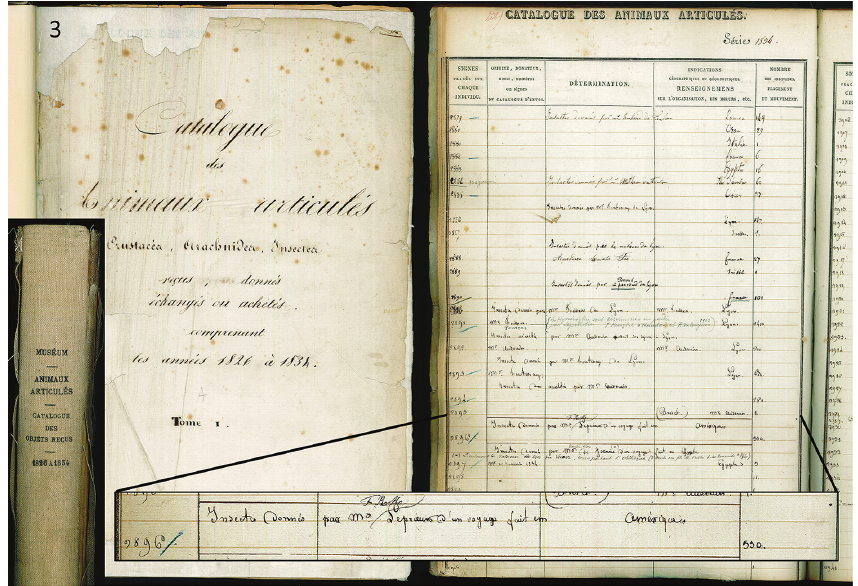
Figure 3. Catalogue des Animaux articulés Crustacéa, Arachnidea, Insectea, reçus, donnés échangés ou achetés comprenant les années 1826 à 1834. Tome I. 3 Spine (far left), front page (left side), page from the “Série 1834” (right side) containing the line for accession number 2896